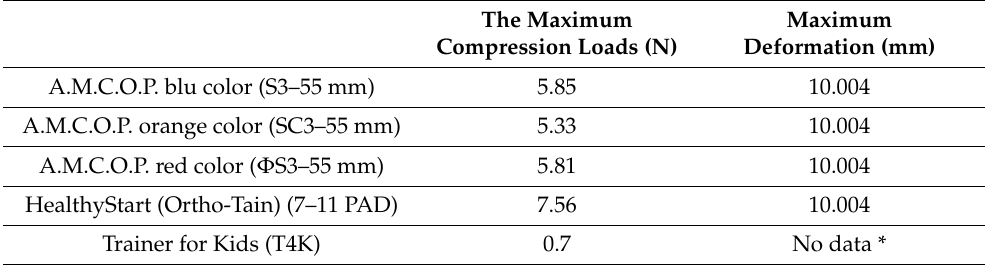
Table 1. Maximum compression load (in N) and deformation obtained during the test.